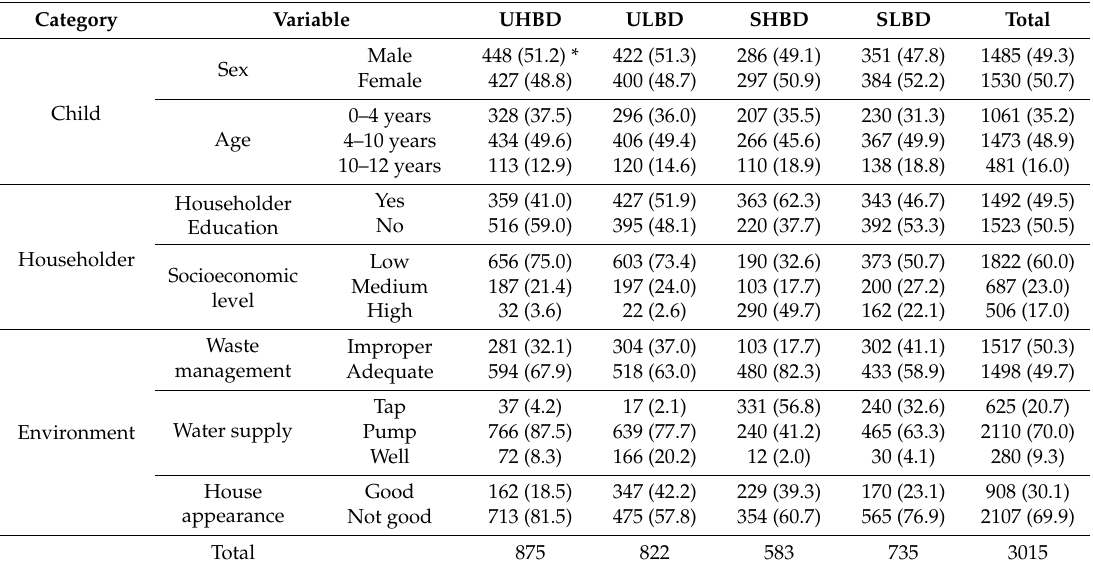
Table 1. Characteristics of the study population in the four